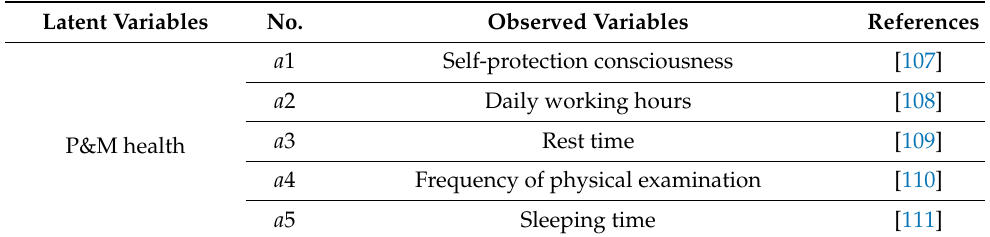
Table 1. Corresponding model variables. P&M, physical and metal (health); SNC, social network and